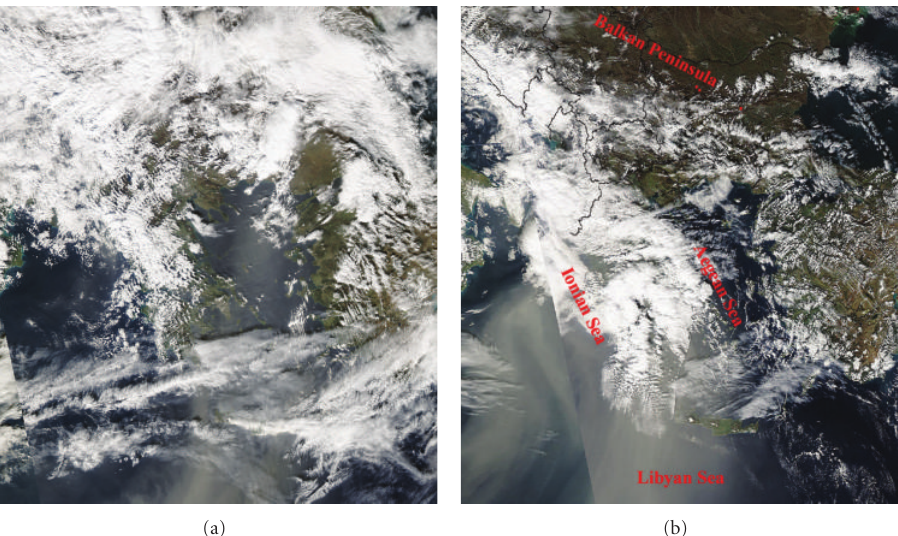
Figure 1: Satellite images from Aqua-MODIS sensor on February 4, 2009 (a) and February 6, 2009